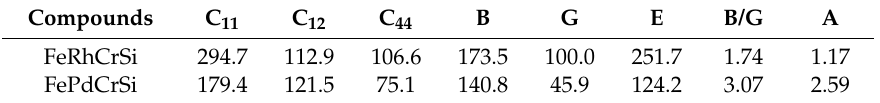
Table 3 The calculated elastic constants C ij , bulk modulus B , shear modulus G , Young’s modulus E (GPa), Pugh’s ratio B/G and anisotropy factor A for the EQH compounds FeRhCrSi and FePdCrSi. Compounds